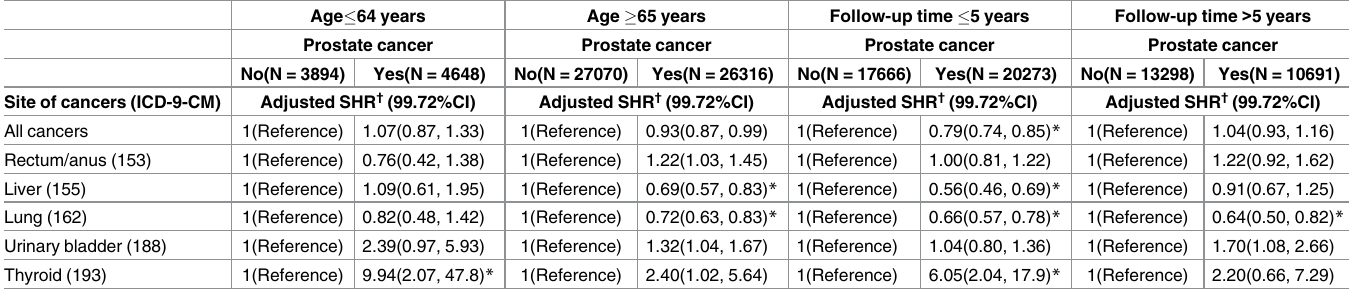
Table 3. Cox proportional subhazards model with subhazard ratios and 99.72%confidence intervals of types of second primary malignancies associatedwith primary prostate cancer stratified by age and follow-up